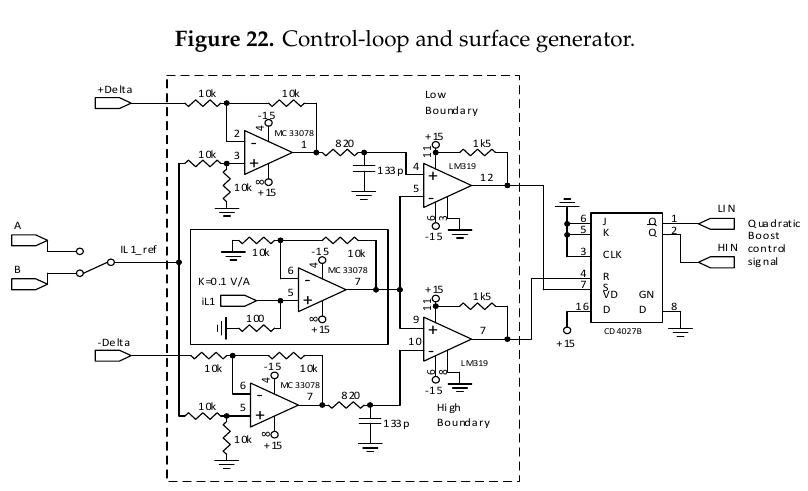
Figure 23. Sliding surface selection and hysteretic comparator.